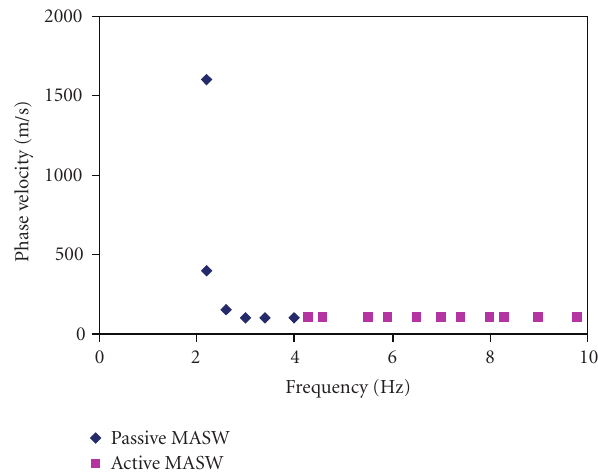
Figure 10: Picked points on the dispersion curve of the fundamen- tal mode of Rayleigh wave for NRC site.